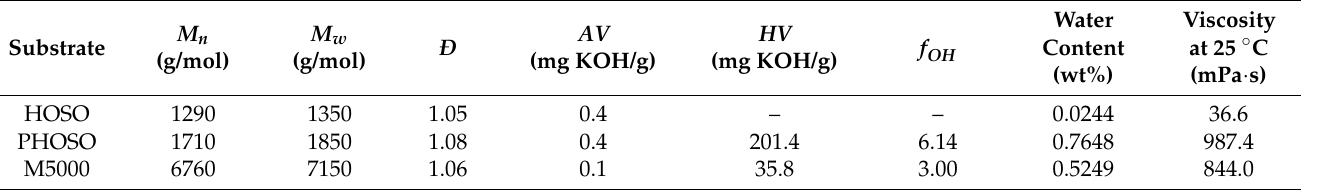
Table 2. Properties of HOSO and polyols: bio-based polyol PHOSO and petrochemical polyol M5000.